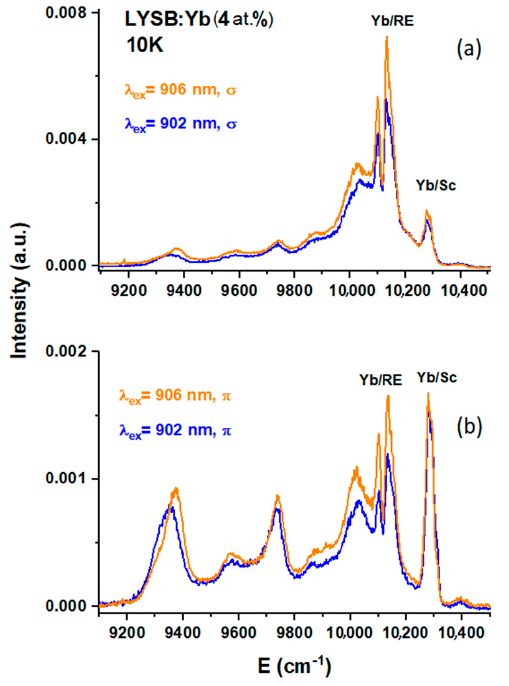
Figure 24. Emission spectra of LYSB:Yb (4 at.%) crystal under selective excitation in σ‐ polarization ( a ) and π‐ polarization ( b ) at 10 K. Adapted with permission from ref. [44], copyright 2020, Elsevier.